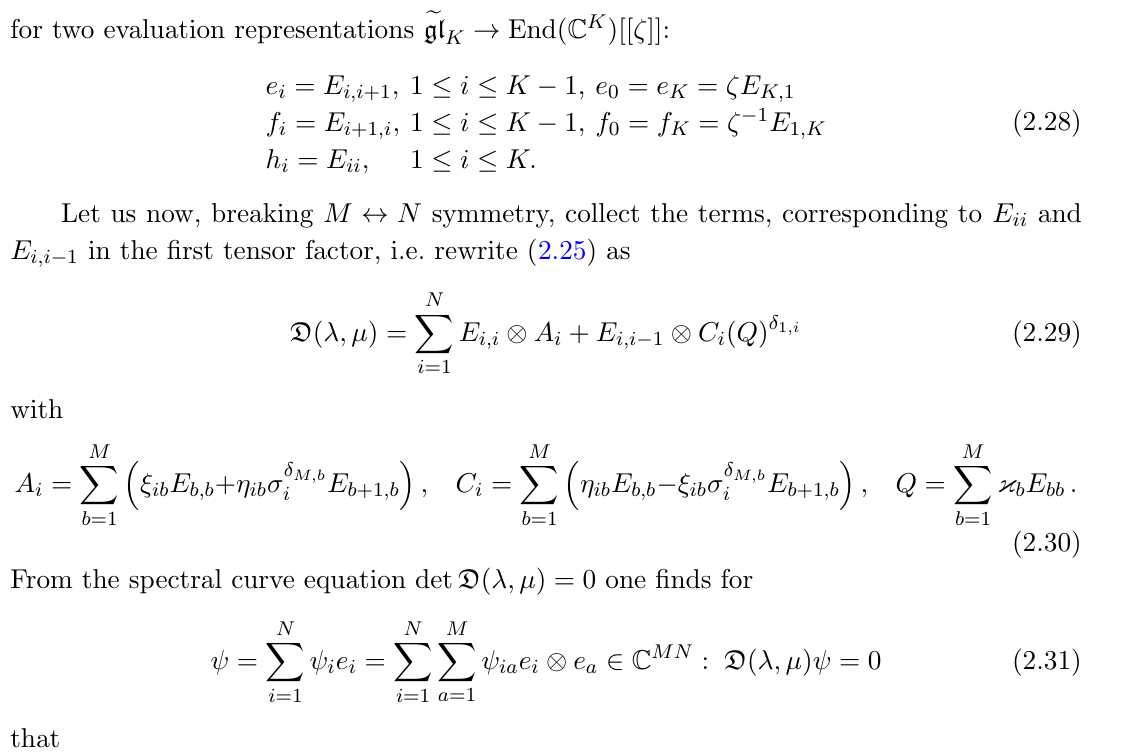
Figure 6 . Left: bipartite graphs with labeled edges and faces: each edge, crossing purple cycle has to be multiplied by (cid:22) , each edge, crossing blue cycle | by (cid:21) . Center: horizontal zig-zag paths. Right: vertical zig-zag